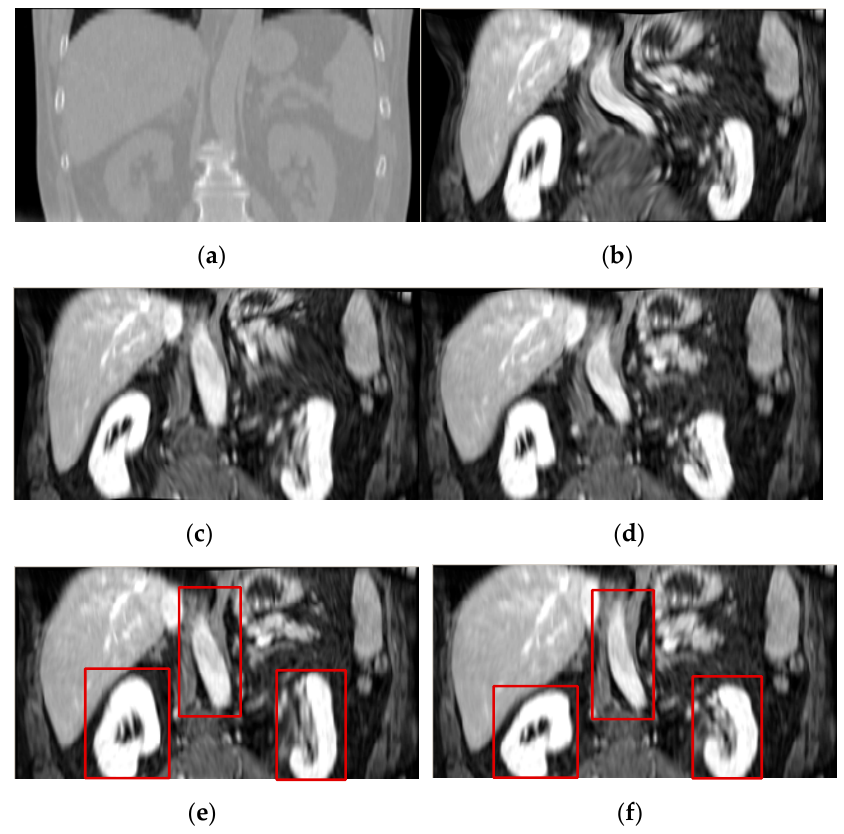
Figure 10. The registration results of all evaluated methods operating on 3D CT–MR images. ( a ) CT image (reference image); ( b ) MR image (float image); ( c ) ESSD; ( d ) MIND; ( e ) HLCSO; and, ( f ) FMIND.